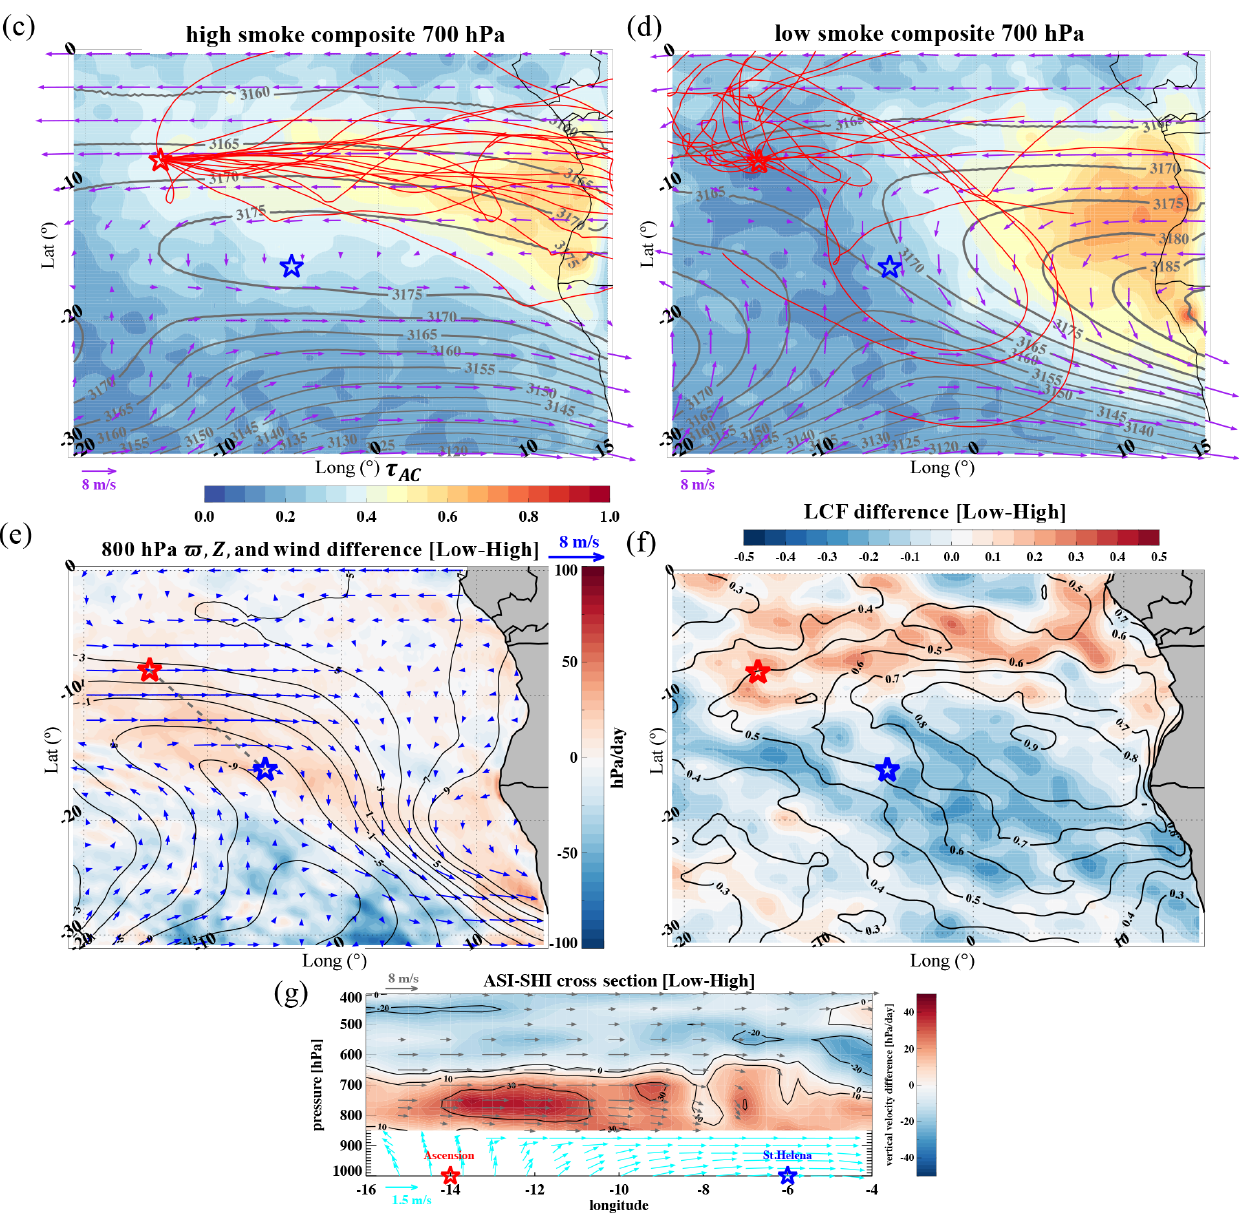
Figure 7. Panels (a) and (b) are as in Fig. 6a and e but for September. Composite mean cloud-top heights and bases included in (a) in kilometers. Composite mean (median) rBC mass concentrations are shown in left panel of (b) . (c, d) HYSPLIT 7d back trajectories initialized at 2km over Ascension at noon for September (red lines) for days with (c) more and (d) less smoke, overlain on composite mean ACAOD (colored contours), 700hPa ERA5 geopotential heights (meters; gray contours) and winds (purple vectors). (e) Low-high smoke composite difference in 800hPa geopotential heights (m; black contours), winds (blue vectors) and vertical velocity (hectopascals per day; hereafter hPad − 1 ; colored background). (f) Low–high smoke composite difference in MODIS daily liquid cloud fraction (LCF; filled-contours), overlain with September mean LCF (black contours). (g) Height cross section of the vertical velocity low–high smoke composite difference (colored background) and zonal or meridional winds (vectors; free tropospheric differences < 2ms − 1 are omitted) between St. Helena and Ascension (red and blue stars, respectively, in c–g